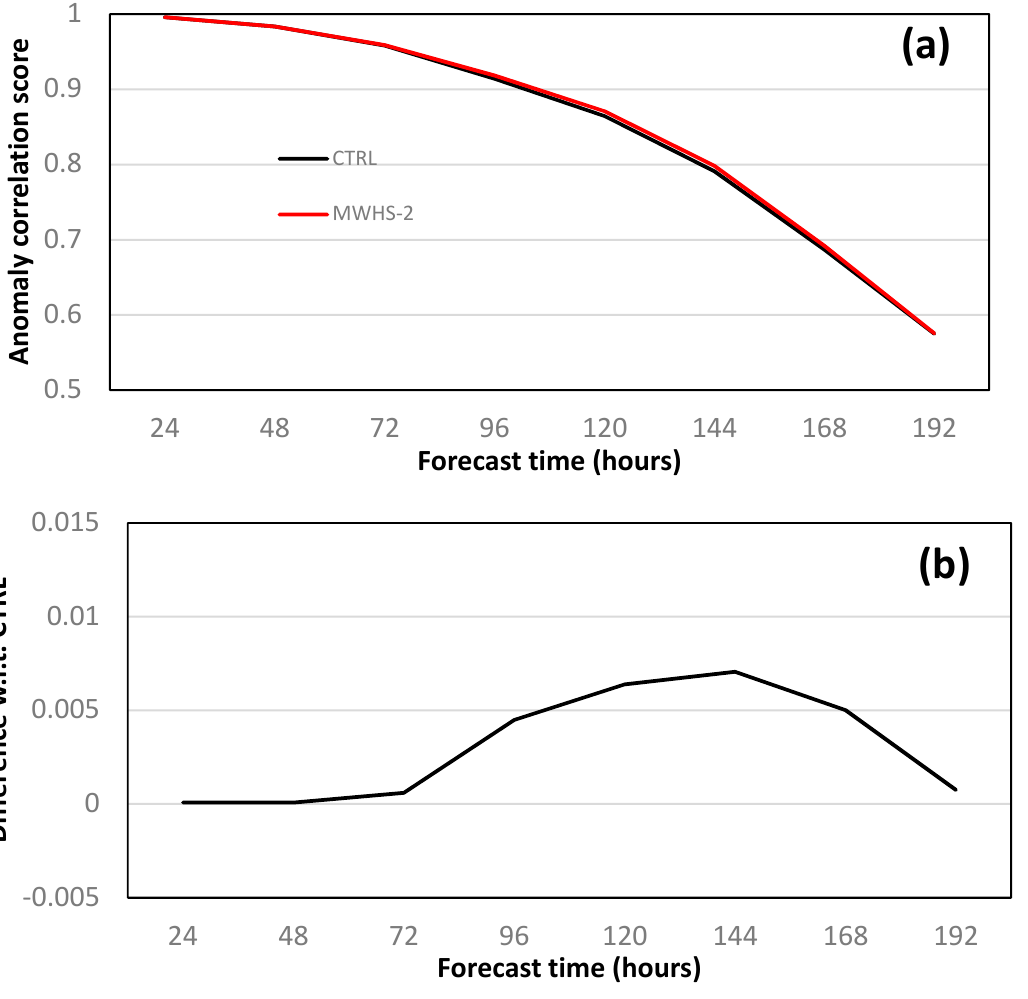
Figure 8. ( a ) Global average of 500-hPa geopotential height anomaly correlation against forecast lead-time for the CTRL (blue line) and MWHS-2 (red line) experiments initialized at 00Z from August 1–5, 2016. ( b ) The di ff erence between the experiments (MWHS-2 minus CTRL).